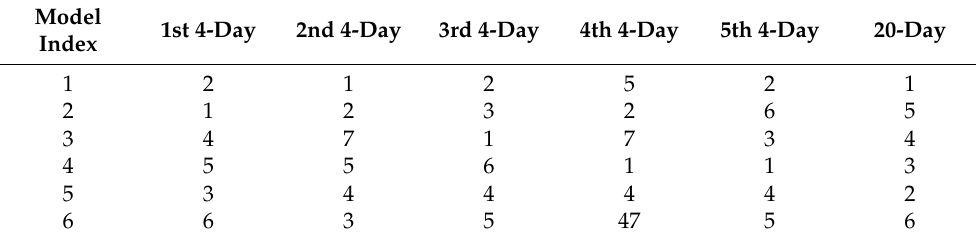
Table 3. Segmental and overall rankings of the top six candidate WRF models as determined using the 20-day wind speed training